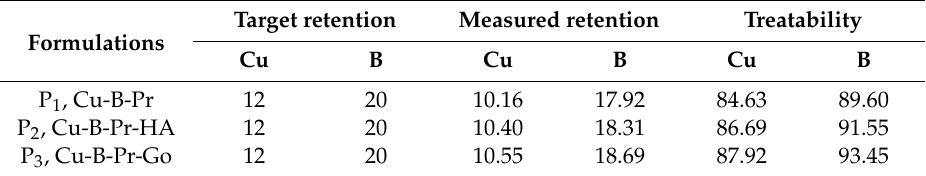
Table 1. Treatability of three formulation feather protein-based wood